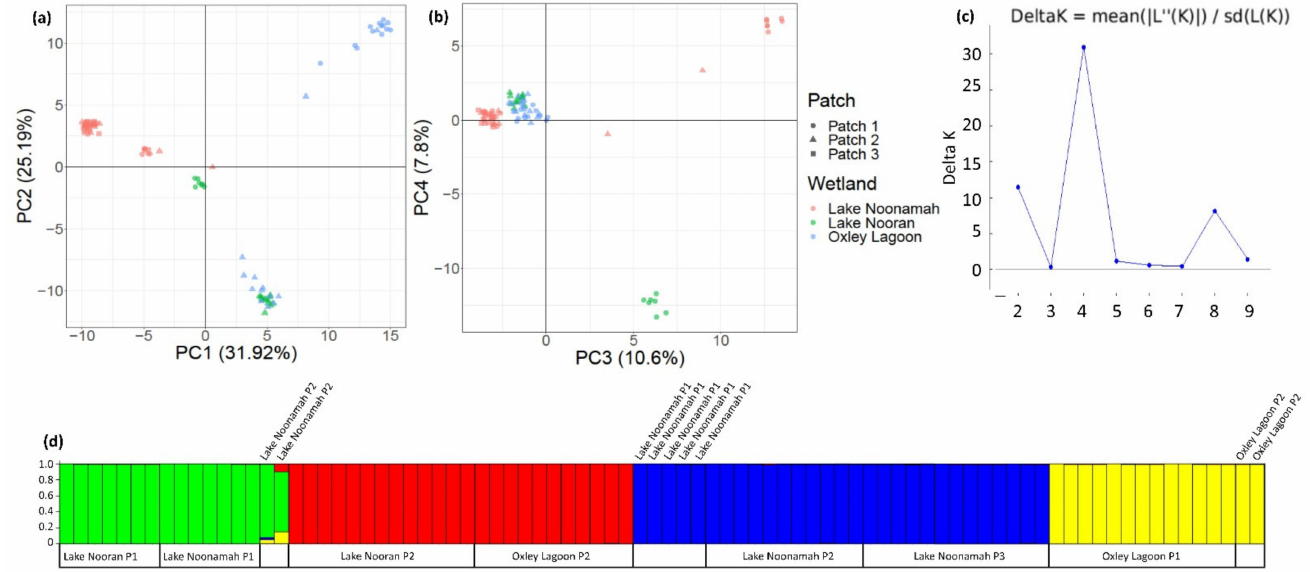
Figure 3. Plots showing ( a ) axes 1 and 2 and ( b ) axes 3 and 4 from PCoA analysis of 84 Marsilea drummondii genotypes across three wetlands (2–3 patches per wetland) in the lower Lachlan River Catchment; ( c ) representation of the Akaike value used to determine the number of populations (K); and ( d ) representation of the probability of population assignment for each individual genotype, coloured by cluster and ordered by wetland and